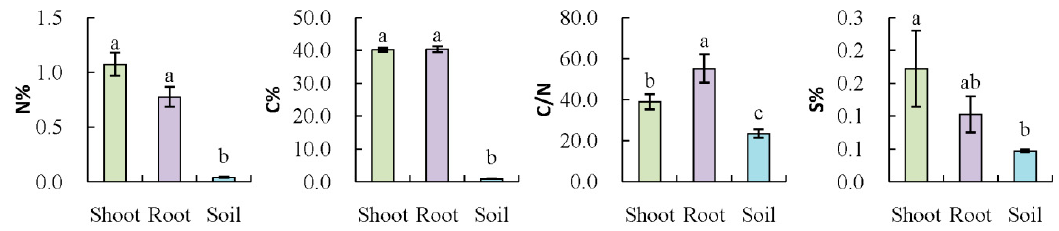
Figure 1. Mean ( ± SE) of total nitrogen (N), total carbon (C), ratio of carbon and nitrogen (C/N), and total sulphur (S) in shoot, root, and soil of B. ischaemum . Different letters indicate significant differences according to Duncan’s test ( P < 0.05).